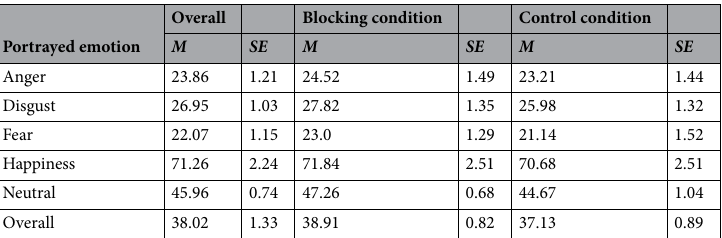
Emotion intensity Valence